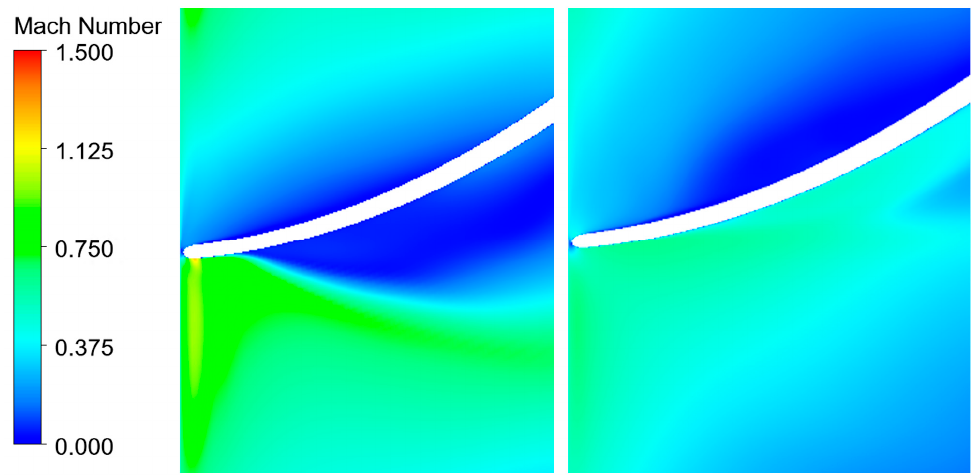
Figure 9. Rotor blade tip Mach number at 100% ( left ) and 70% ( right ) mass flow rates.